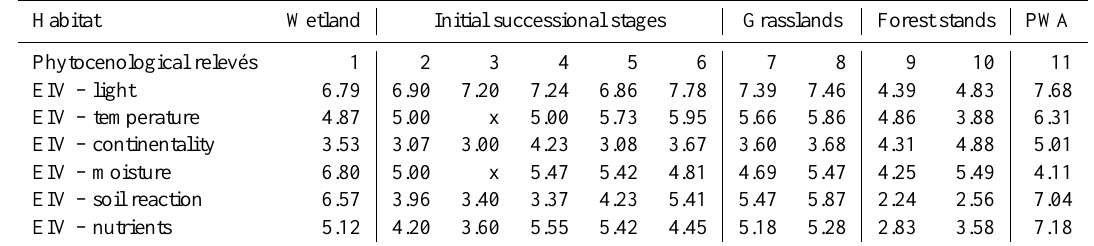
Table 4. Ellenberg indicator values for individual sites (PWA is a place for feeding wild animals, EIV is the Ellenberg indicator value). × means that there are no taxa in a site with the allocated respective EIV. Habitat Wetland Initial successional stages Grasslands Forest stands PWA